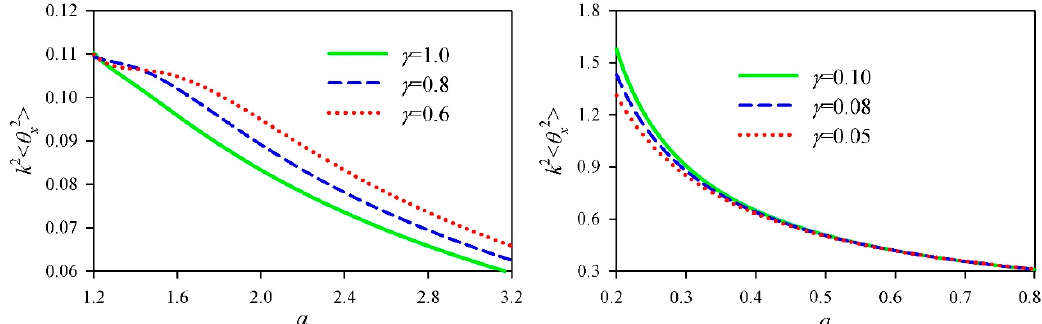
Figure 6. By giving the decay factor a , the square of the divergence in the x- direction of the cosh-Airy beam as a function of the cosh parameter γ is shown.